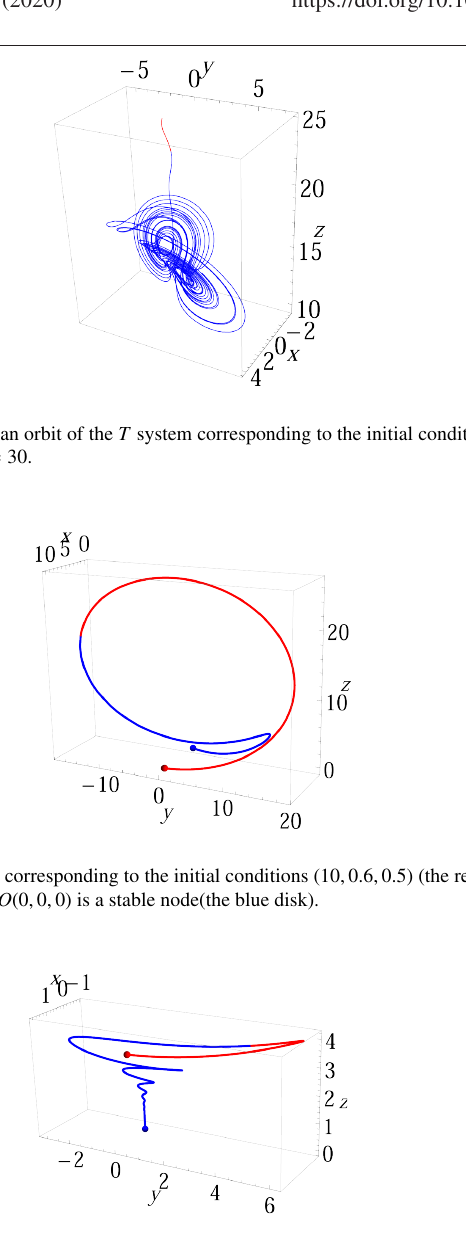
Figure 3. A stabilized trajectory corresponding to the initial conditions (1 . 8 , 0 . 6 , 3 . 5) (the red disk) and parameters a = 2 , b = 0 . 2 , c = 30 , k = 3; O (0 , 0 , 0) is a stable focus-node (the blue